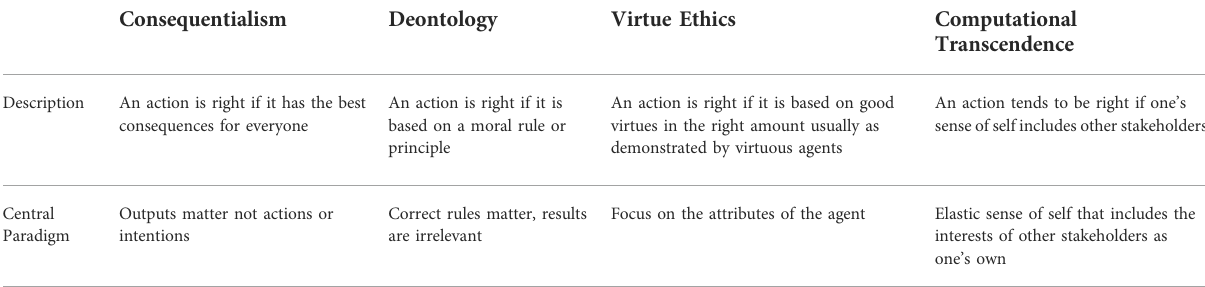
TABLE 1 Comparison between different models of ethics and computational